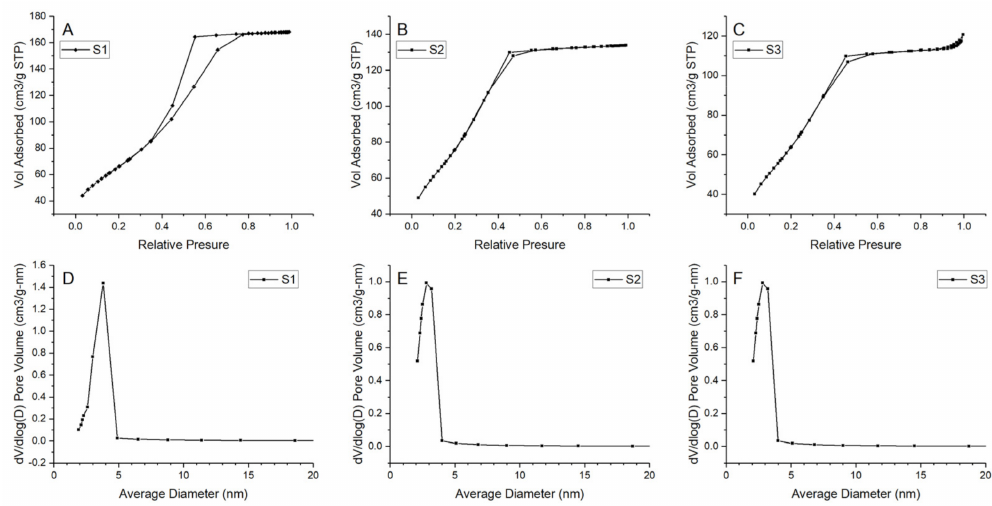
Figure 12. N 2 adsorption–desorption isotherms and pore size distribution for the samples ( A ), ( D )